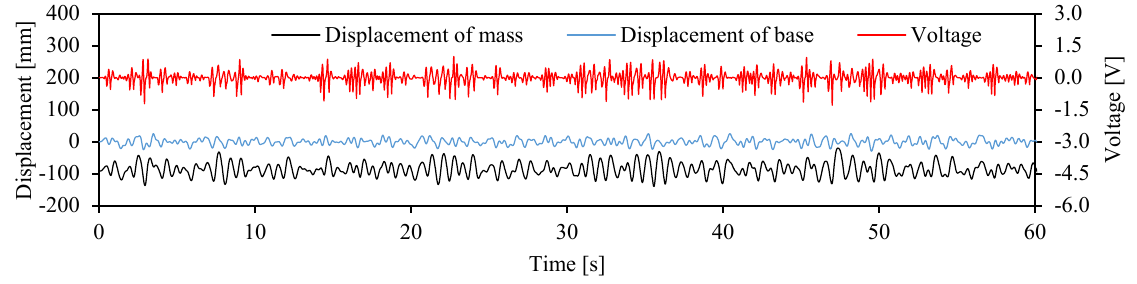
The number of occurrences of bi-stable vibration in the mass block began decreasing as the periodic signal frequency approached 1.9 Hz, as presented in Figure 21, with stand- ard deviations of 80.74 and 10.92 mm for the vibration displacements of the mass block and support point, respectively, which resulted in 3.76 mW of power generated. When the periodic signal frequency shown in Figure 22 approached 2.2 Hz, the vibration of the mass block reduced, the bi-stable vibrations disappeared, and the mass block indicated monostable vibrations. The standard deviations of the vibration displacement of the mass block and support point were 20.70 and 9.84 mm, respectively, which resulted in 2.18 mW of power generated. Figure 21. Results based on co-excitation of random and 1.9 Hz periodic signals.